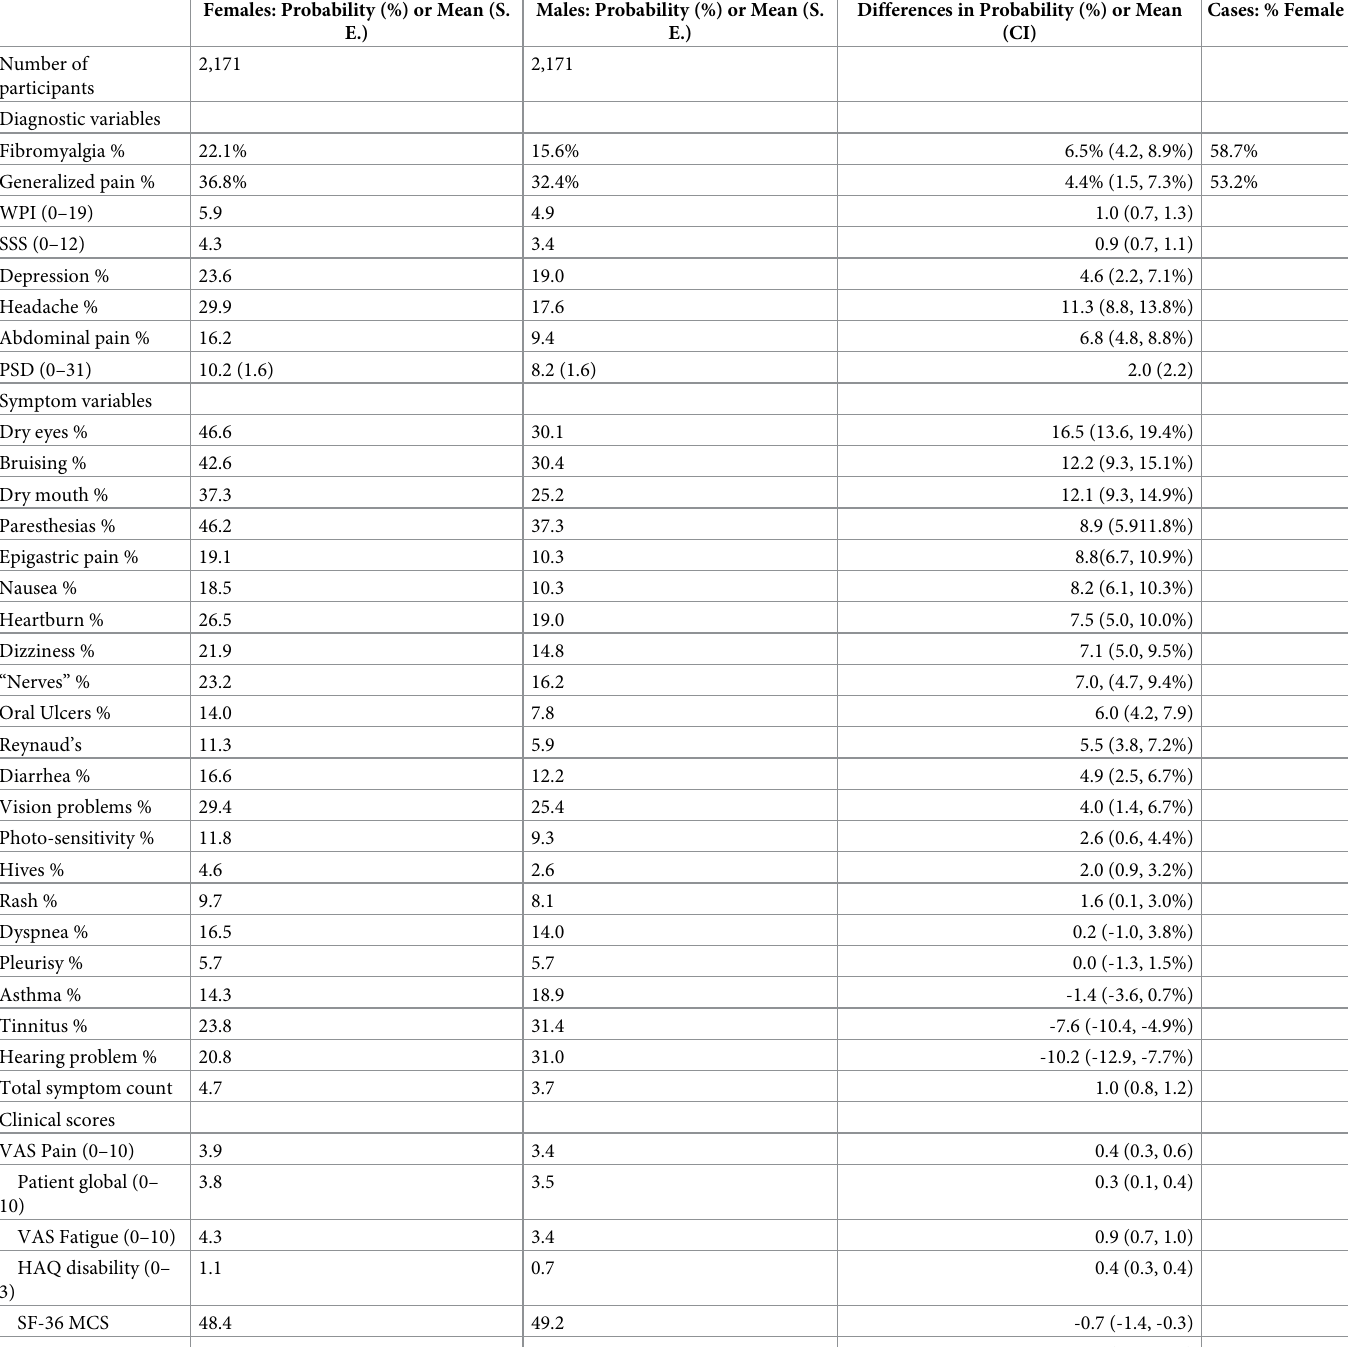
Table 1. Probabilities, symptoms and symptom score related to fibromyalgia according to gender among RA patients in the National Data Bank for Rheumatic Dis- eases (S2 File). Females: Probability (%) or Mean (S. Males: Probability (%) or Mean (S. Differences in Probability (%) or Mean Cases: % E.) E.) (CI)